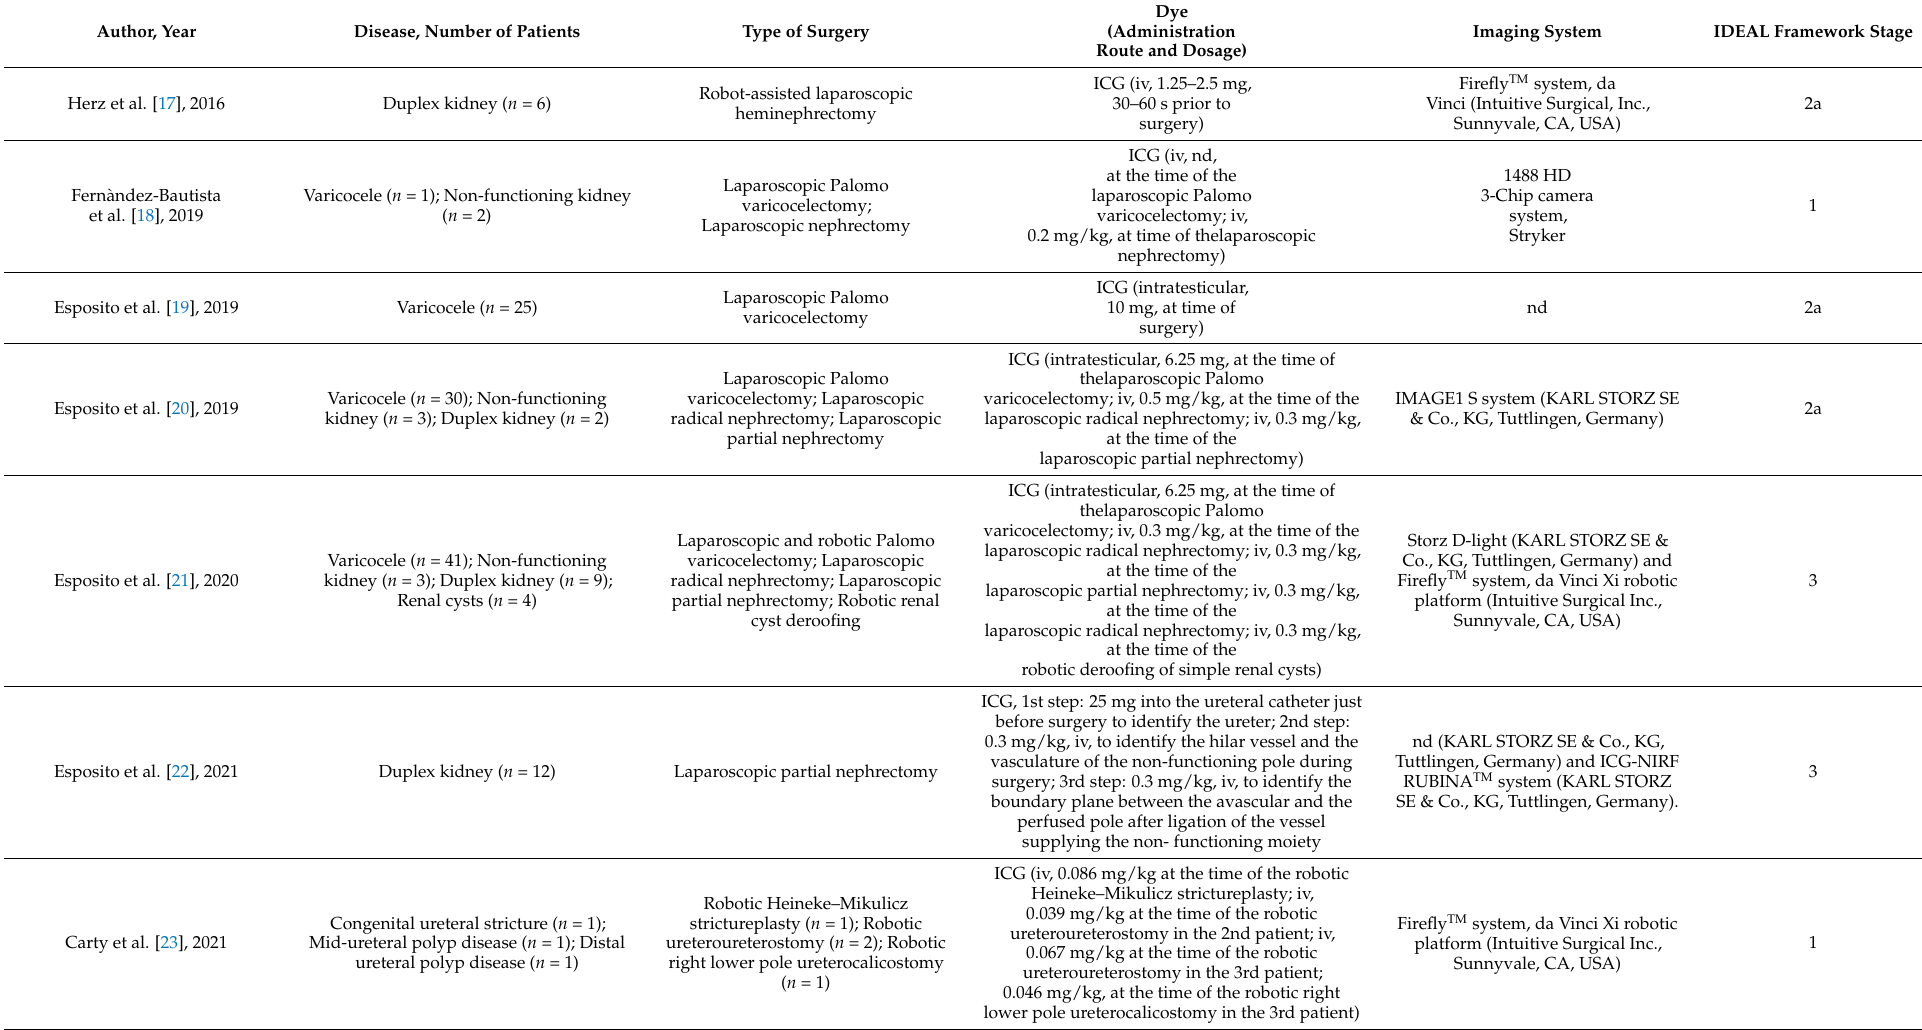
Table 1. Selected scientific articles focusing on Fluorescence-guided surgery (FGS) in the field of pediatric